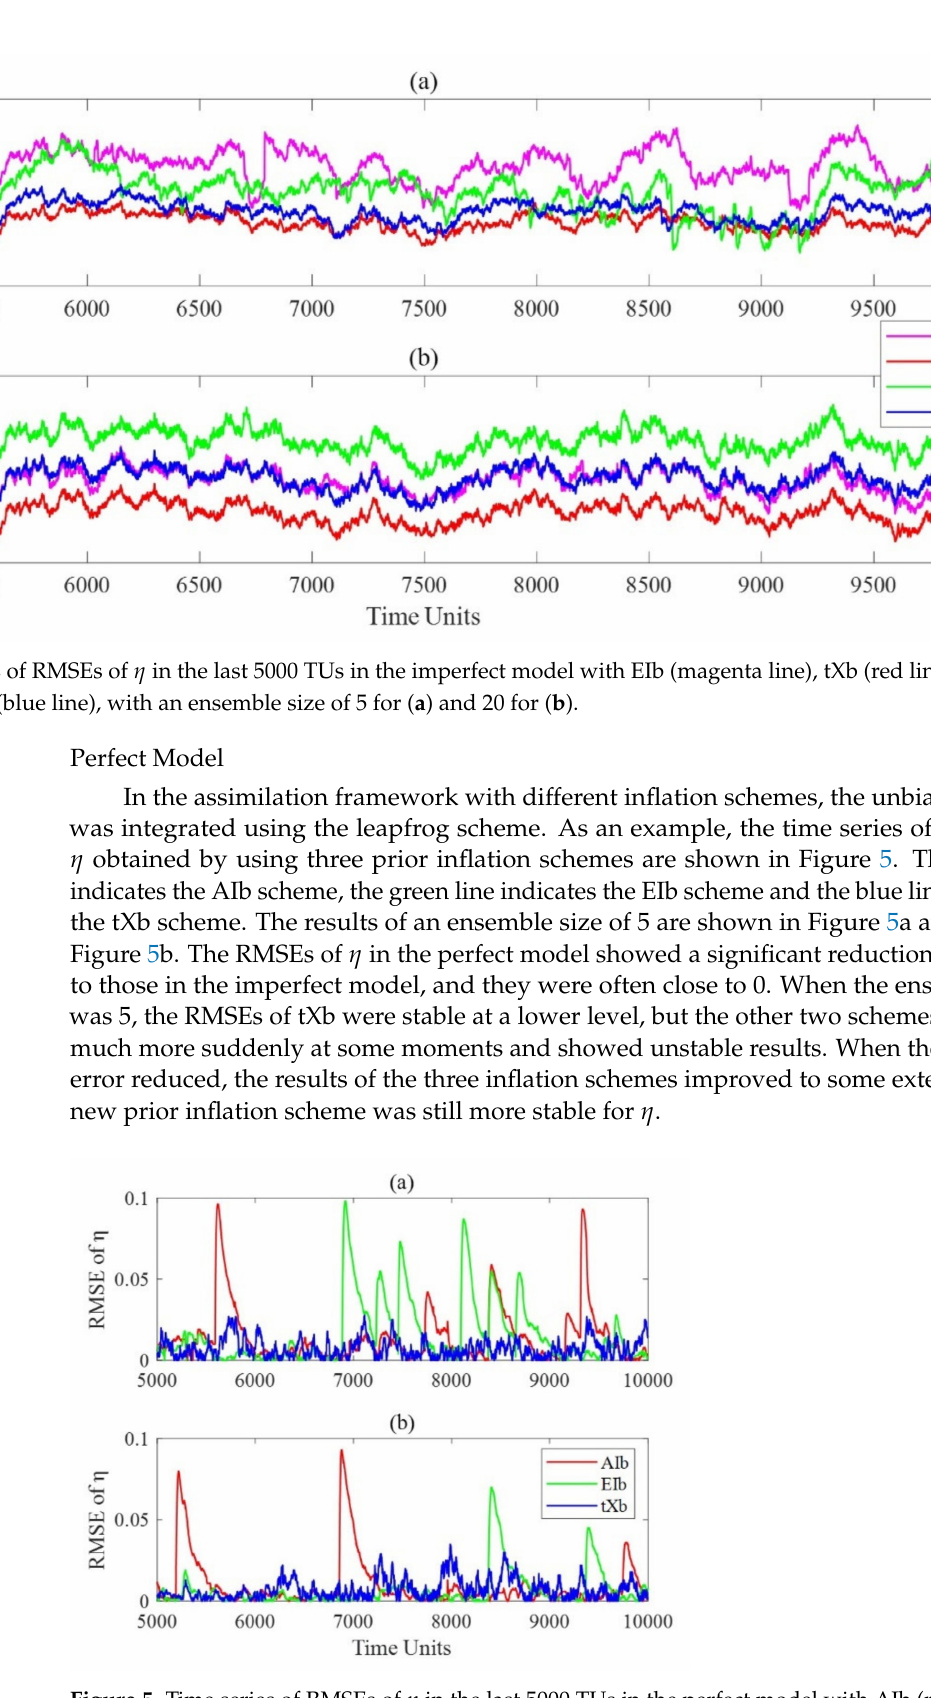
Figure 5. Time series of RMSEs of η in the last 5000 TUs in the perfect model with AIb (red line), EIb (green line) and tXb (blue line), with an ensemble size of 5 for ( a ) and 20 for ( b